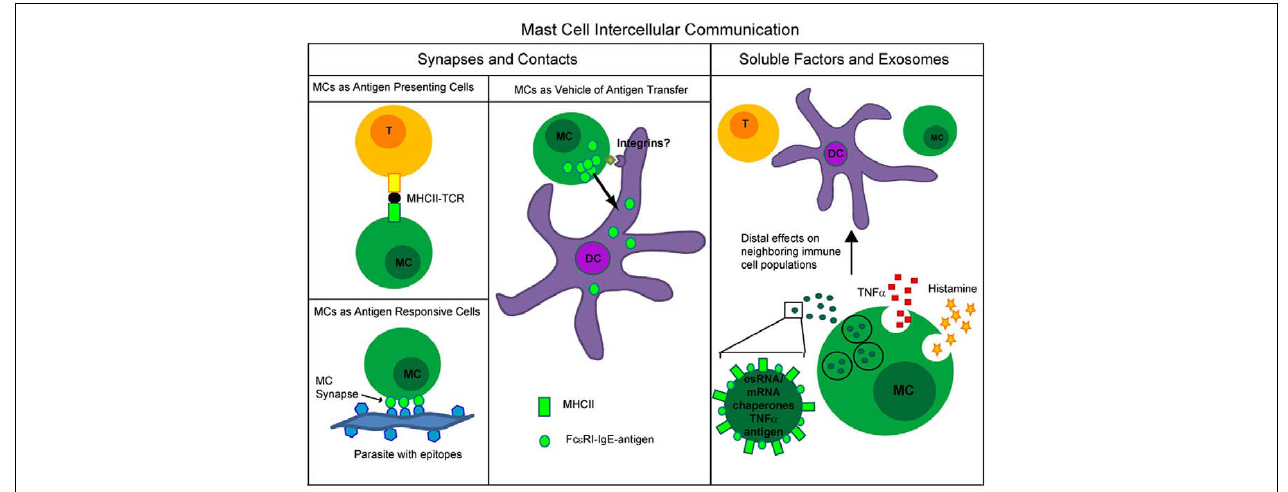
FIGURE 4 | Summary of types of mast cell intercellular communication occurring through formation of synapses or direct contacts versus through soluble factors or mast cell